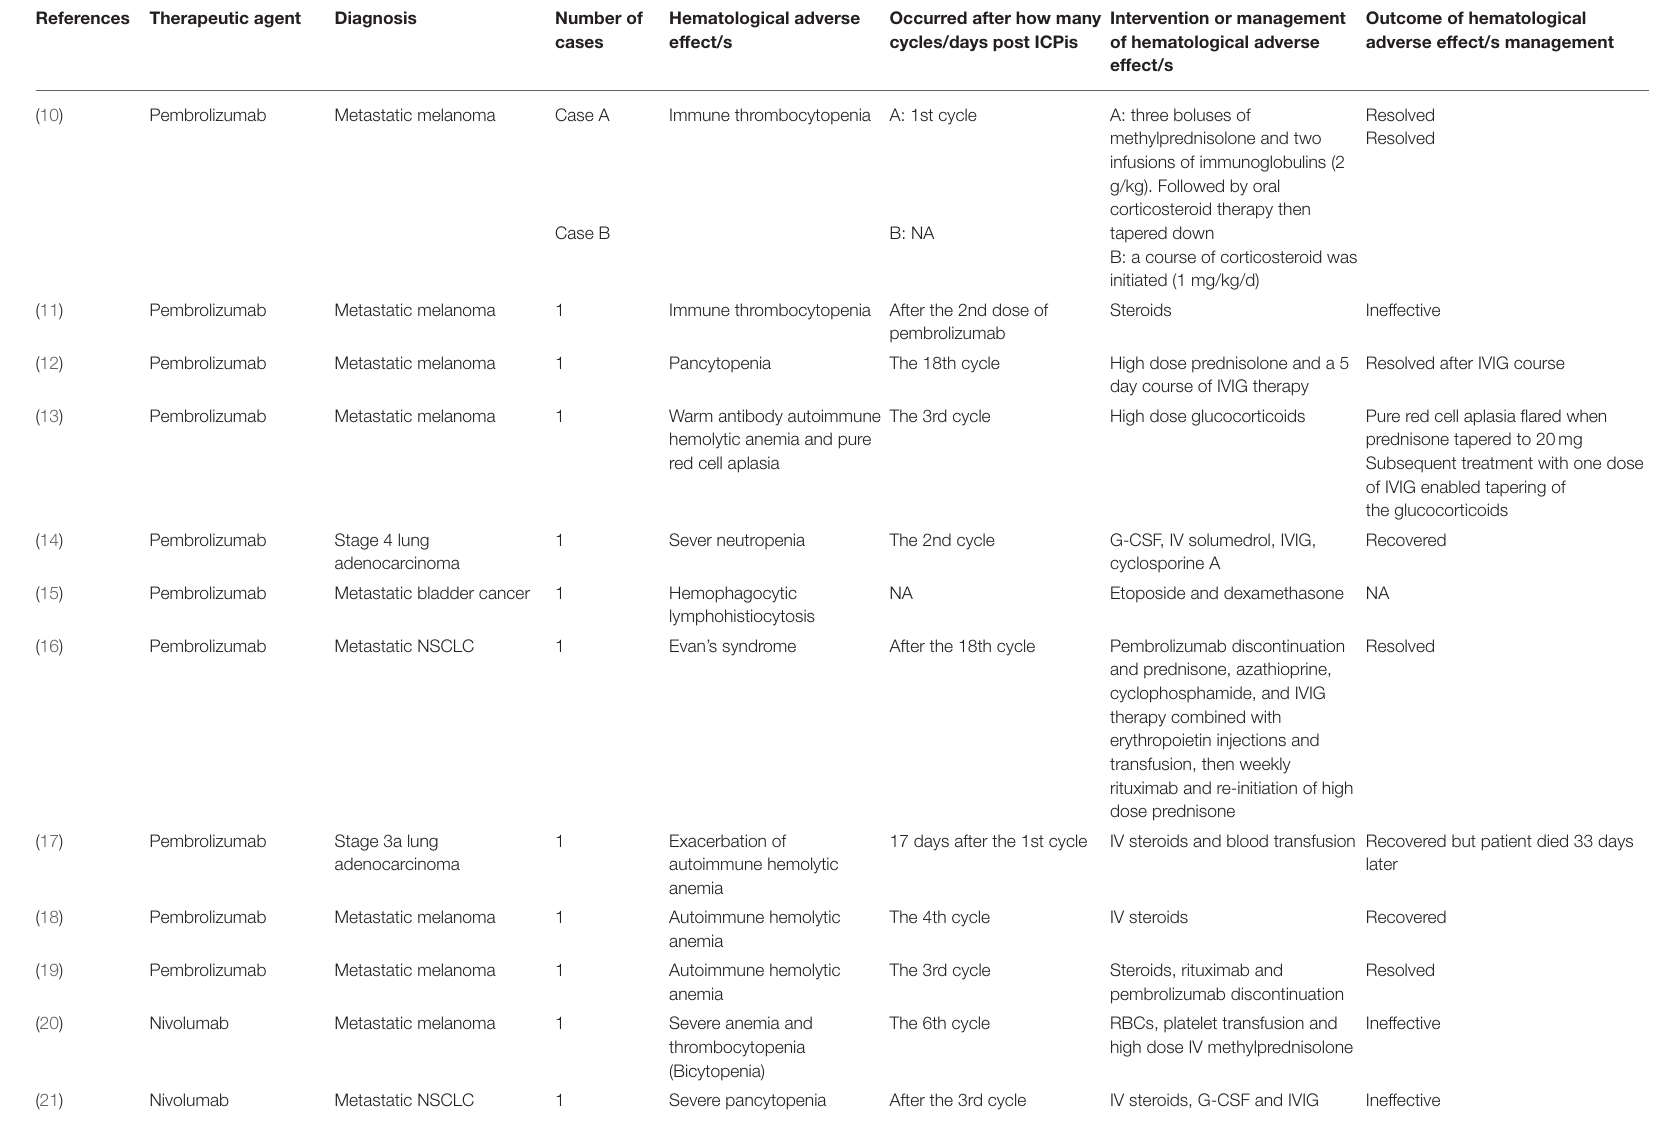
TABLE 1 | Summary of available literature about immune check point inhibitors-associated hematological adverse